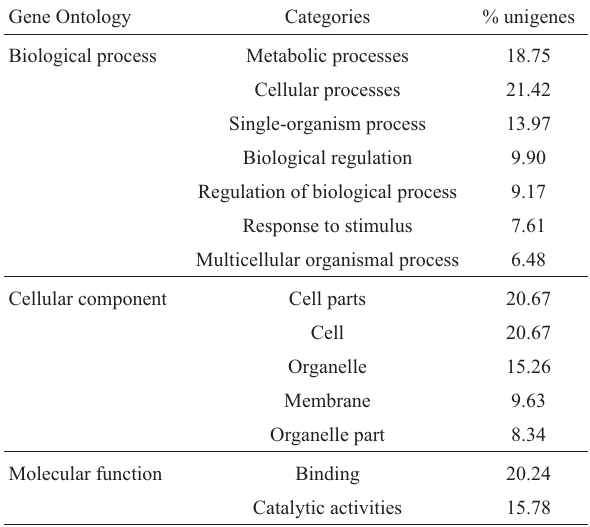
Table 4 - Functional annotation of assembled sequences based on gene ontology (GO) categorization.